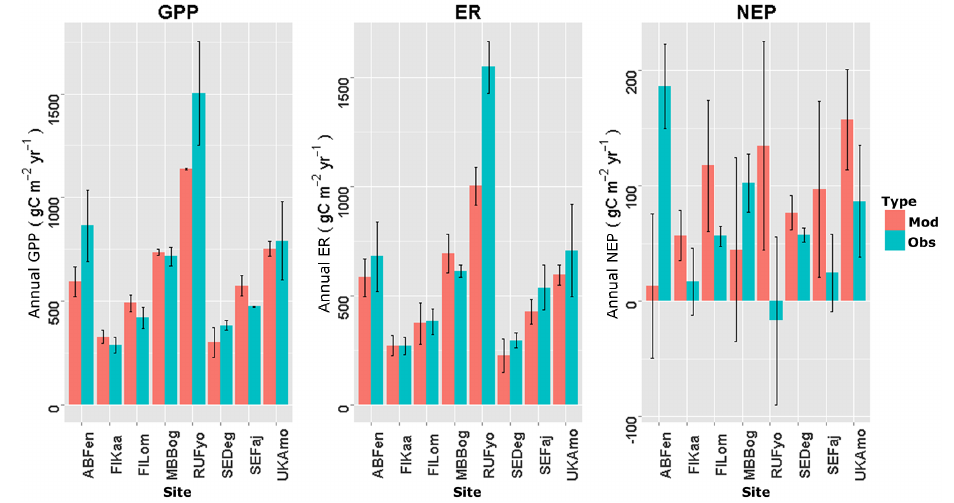
Figure 16. Observed and simulated annual GPP, ER, and NEP (gCm − 2 yr − 1 ) for the eight sites (error bars show the standard deviations); red bars are modelled fluxes and blue bars are observed fluxes.